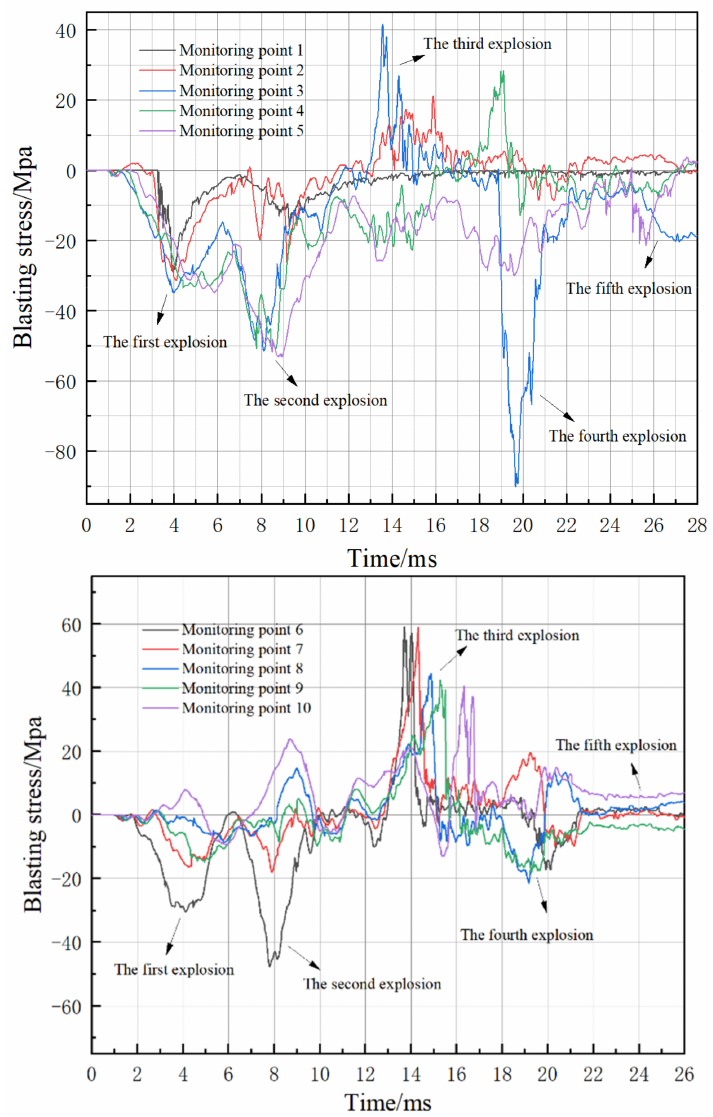
Figure 10. Explosion stress monitoring